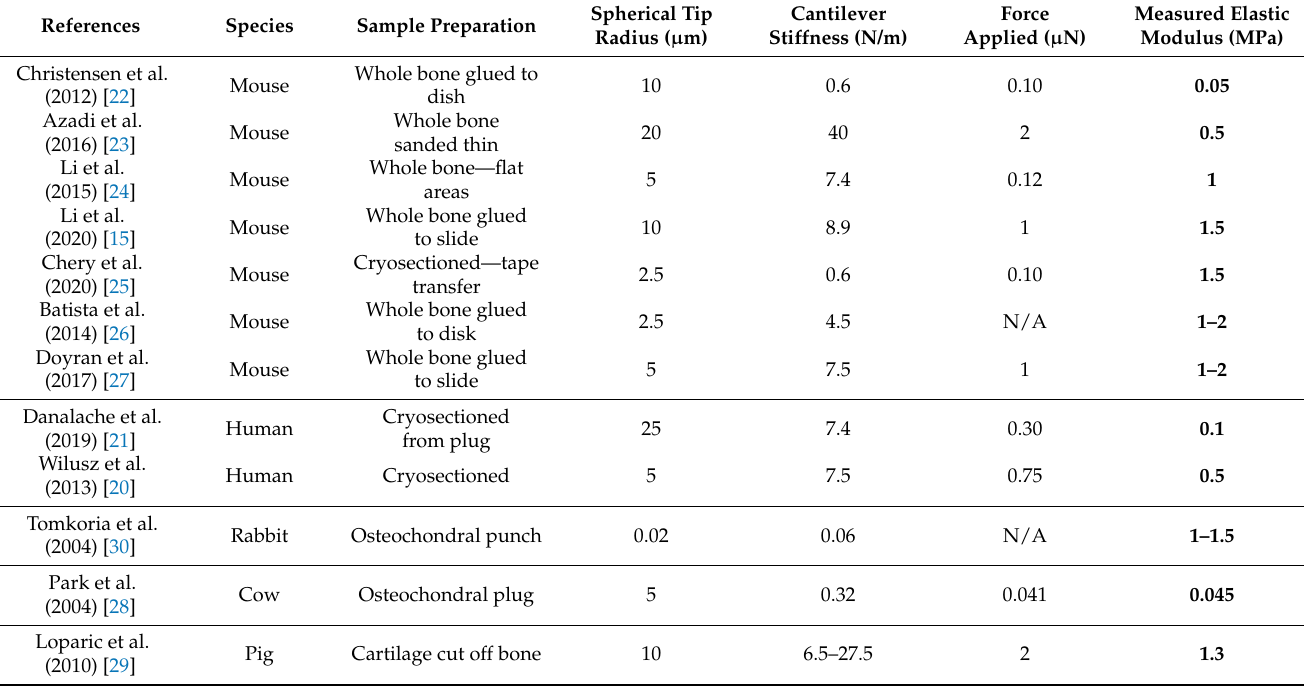
Table 1. Summary of AFM methodology in 12 studies of articular cartilage where experimental parameters were